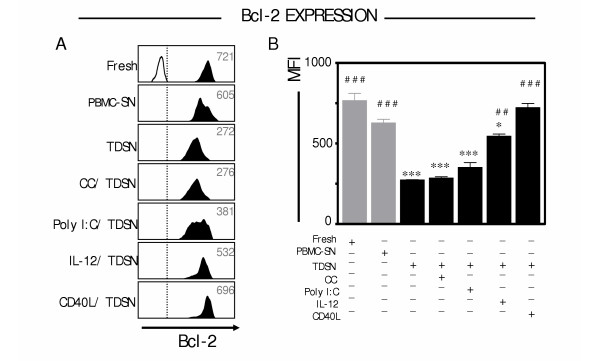
Effect of tumor-derived supernatant (TDSN) and stimulation on expression of Bcl-2. (a)Expression of Bcl-2 in blood dendritic cells (DCs) was determined: ex vivo (Fresh); following culture (24 h) in the presence of 50% (v/v) peripheral blood mononuclear cell-conditioned supernatant (PBMC-SN) or TDSN (MA11); or following stimulation (24 h) with a cytokine cocktail (CC), synthetic double-stranded RNA (poly I:C), IL-12 or CD40 ligand (CD40L) prior (24 h) to culture with 50% (v/v) TDSN. Representative histograms (filled) are shown with numbers indicating the mean fluorescence intensity (MFI) of Bcl-2 expression. The unfilled histogram shows staining with isotype control. (b)Summary of Bcl-2 expression data. Results show the average ± standard error of the mean of five independent experiments for which statistically significant differences compared to fresh cells (*, p < 0.05; ***, p < 0.001) or after incubation with TDSN (##, p < 0.01; ###, p < 0.001) are indicated.